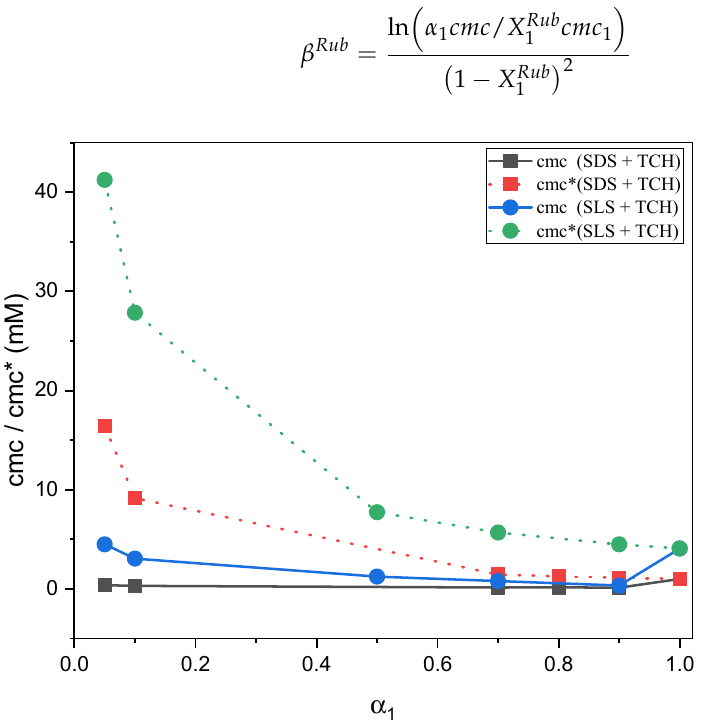
Figure 4. Experimentally determined critical micelle concentration ( cmc ) and ideal critical micelle concentration ( cmc* ) against mole fraction of surfactants (SDS/SLS) in mixed systems at 298.15 K. The micellar mole fraction of component 1 is represented by X Rub